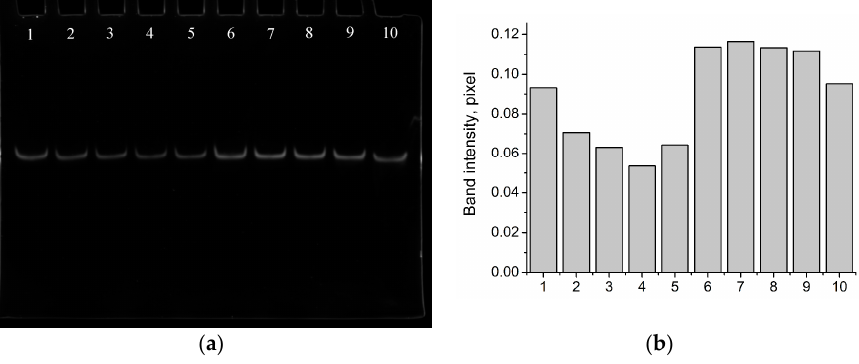
Figure 2. Nondenaturating PAGE (photo without any modification) of the PCR amplified (16 cycles) washout probes from the magnetic beads modified with B1/Van_74 ( a ) and image analysis of phoresis with GelQuant.NET ( b ) for different incubation buffers: (1) Selection buffer with vanillin (1.5 mM); (2) Selection buffer with vanillin (1.5 mM), repeat; (3) Selection buffer; (4) Selection buffer, repeat; (5) Selection buffer, repeat; (6) Bsm buffer with vanillin (1.5 mM); (7) Bsm buffer with vanillin (1.5 mM), repeat; (8) Bsm buffer; (9) Bsm buffer, repeat; and (10) Bsm buffer, repeat.